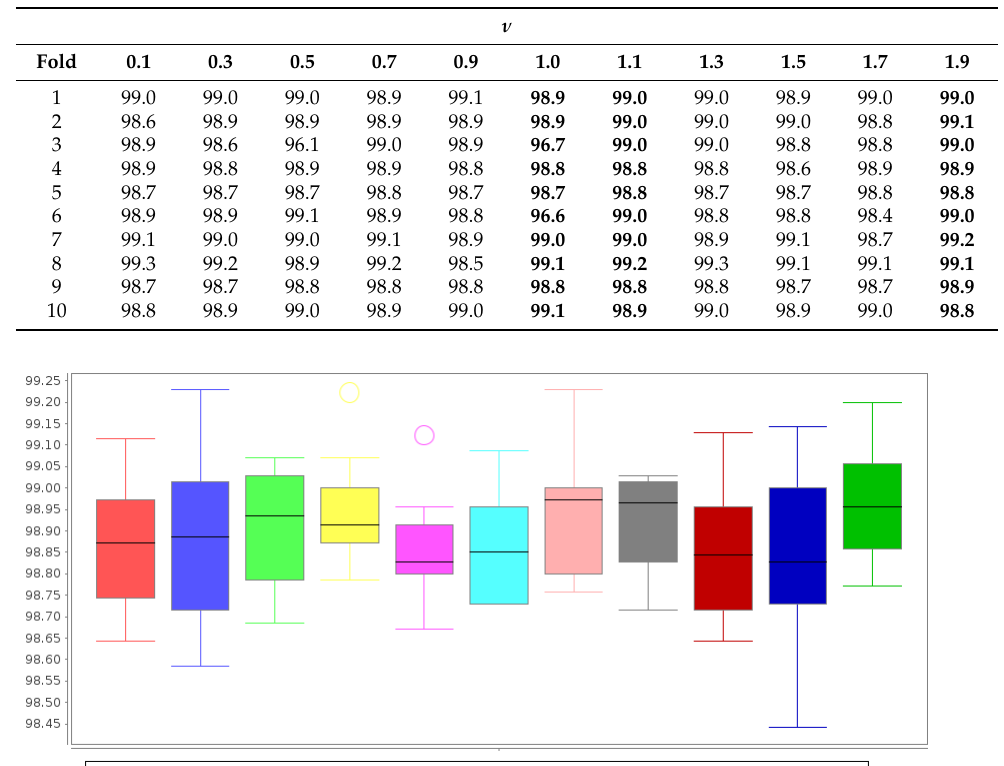
Table 3. Experiment 1.2: Comparison between SGD and FSGD with η = 0.1 and momentum γ = 0.1. The case ν = 1.0 corresponds to SGD.